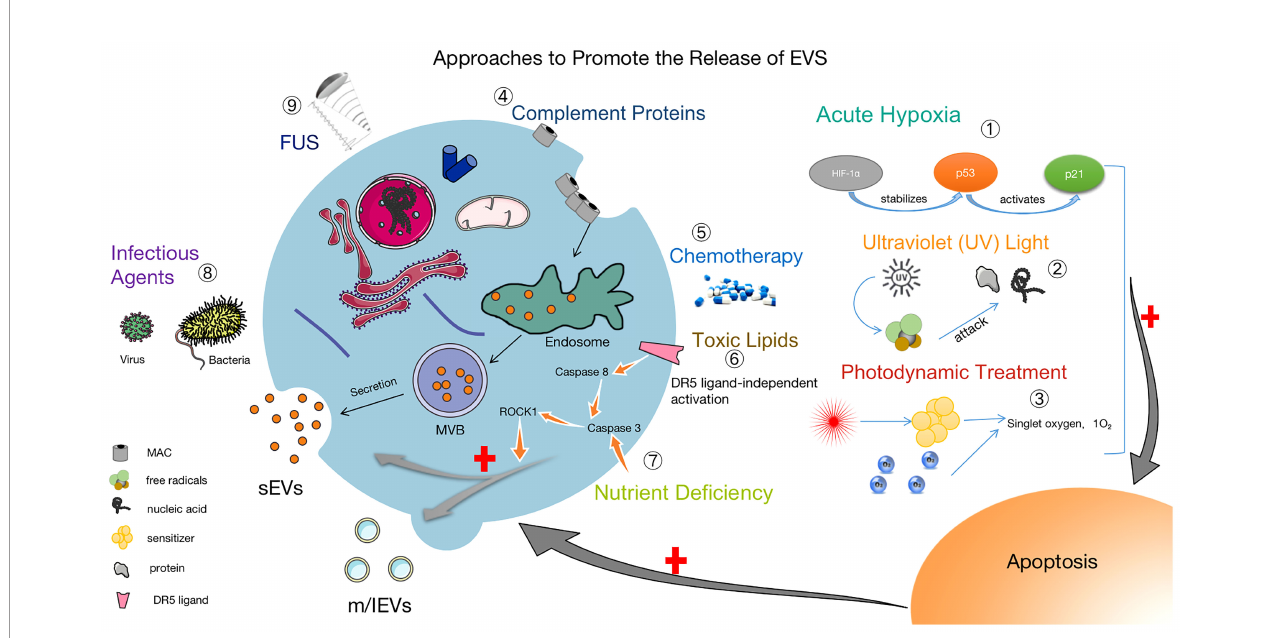
FIGURE 2 | Methods to facilitate the release of EVs. ① Acute Hypoxia: Catabolism of HIF-1 a is inhibited by acute hypoxia, which stabilizes the P53 gene and activates the P21 gene, leading to apoptosis and promoting the release of EVs (91 – 93). ② UV: After UV irradiation, a large number of free radicals are generated to attack nucleic acids and proteins, causing apoptosis and increasing the release of EVs (94). ③ Photodynamic Treatment: Laser irradiation at a speci fi c wavelength excites the tissue-absorbing photosensitizer, and the excited state of the photosensitizer transmits energy to the surrounding oxygen, generating strongly reactive monomorphic oxygen, which may reacts oxidatively with the surrounding neighboring biomolecules, resulting in a cytotoxic effect that causes apoptosis and also promoting the release of EVs (95). ④ Complement Proteins: The membrane attack complex (MAC) is composed of complement proteins (C5b, C6, C7, C8 and C9). MAC is cleared from the cell surface by cytosolic or cytocytic action to help release EVs (96, 97). ⑤ Chemotherapy: The use of chemotherapeutic agents (e.g., doxorubicin, methotrexate, and cisplatin) causes cellular damage and EVs release (95, 98). ⑥ Toxic Lipids: Toxic lipids activates the DR5 pro-apoptotic signaling cascade, which in turn activates ROCK1 and promotes the release of EVs from hepatocytes (90). ⑦ Nutritional De fi ciency: Activation of Caspase 3, ROCK1 signaling pathway and promotion the release of EVs (99). ⑧ Infection factors (100) and ⑨ focused ultrasound (101) can also promote the release of